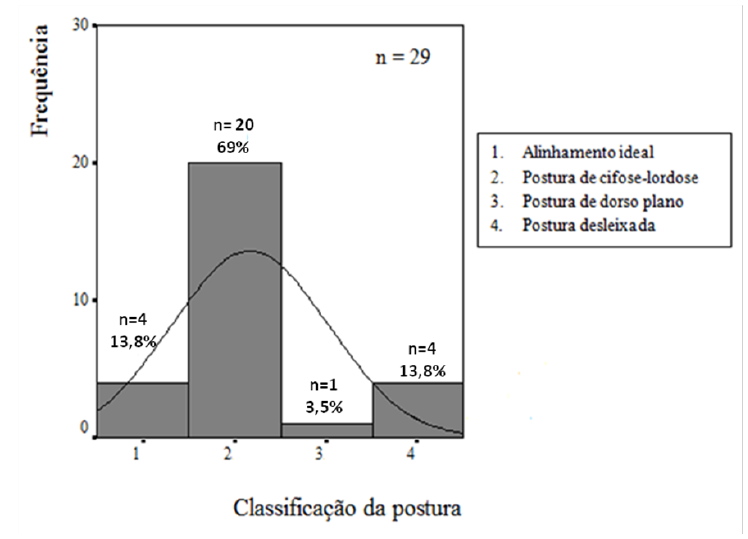
Figura 2. Classificação da postura corporal das idosas participantes do GEF.